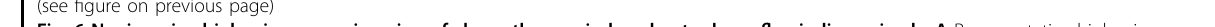
gradually reduced till the administration of second combinatorial dose on day 7, following which a spike in bioluminescence was observed on day 8 (9.58 × 10 6 ± 2.53 × 10 6 p/s/cm 2 /sr, ~2.76-fold) and day 10 (8.41 × 10 6 ± 2.6 × 10 6 p/s/cm 2 /sr, ~2.43-fold). The luminesce signal again spiked on day 14